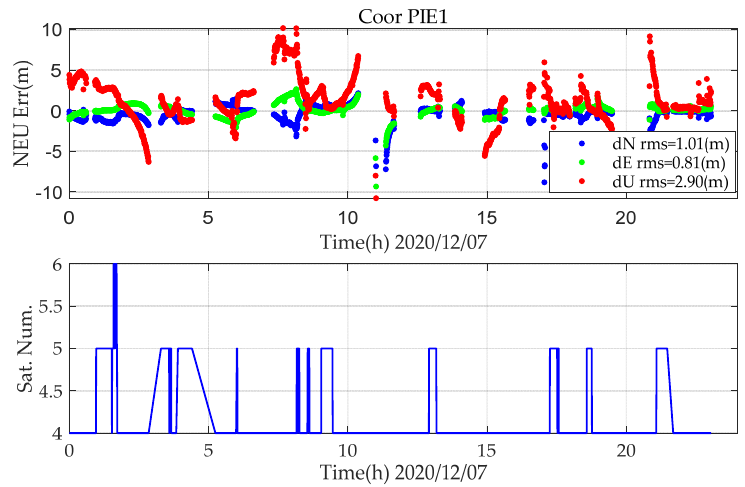
Figure 4. BDS (B1CB2a) kinematic PPP positioning error and number of satellite (DOY342,2020).